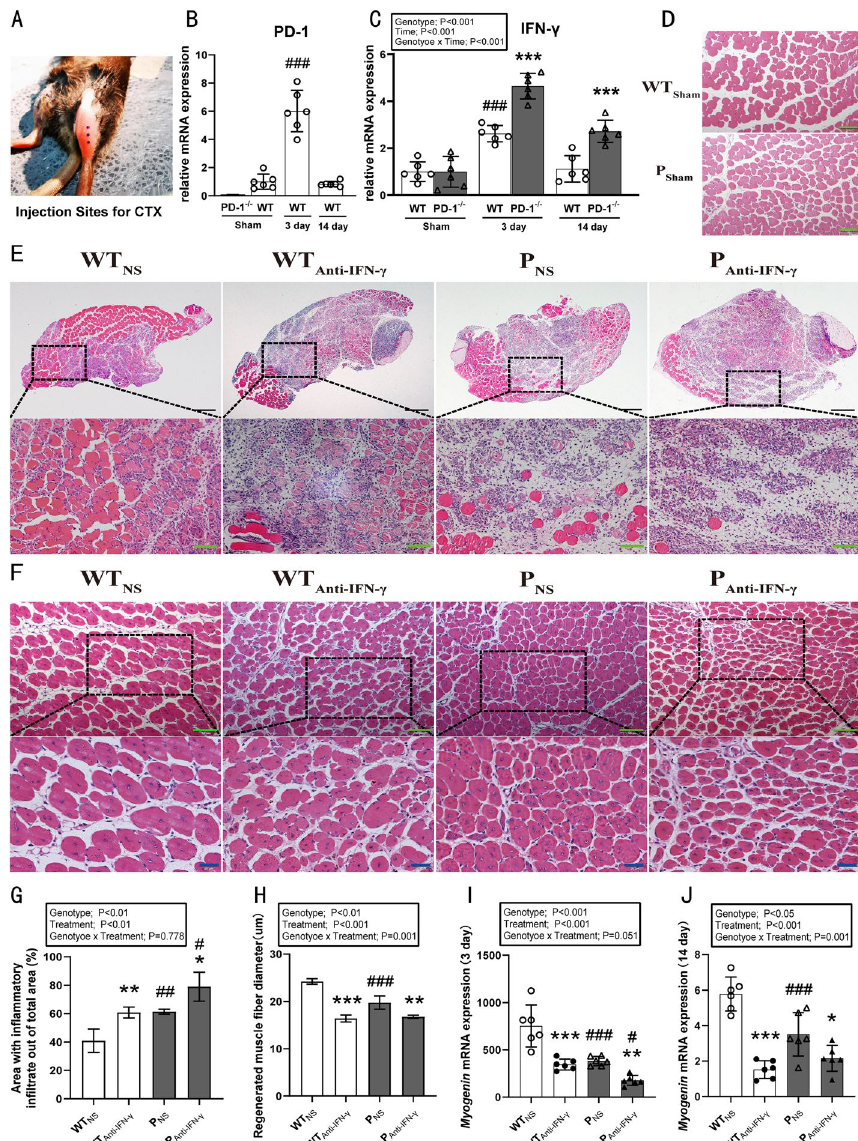
Fig. 1 PD-1 knockout and IFN-γ blockade aggravate muscle damage and impair muscle regeneration. WT Sham : wild-type uninjured group, P Sham : PD-1 − / − uninjured group, WT NS : wild-type injured group with normal saline injection, WT Anti-IFN-γ : wild-type injured group with anti-IFN-γ antibody injection, P NS : PD-1 − / − injured group with normal saline injection, P Anti-IFN- γ : PD-1 − / − injured group with anti-IFN-γ antibody injection. A Injection sites for CTX. B PD-1 mRNA expression in wild-type mice after skeletal muscle injury. C IFN-γ mRNA expression in wild-type mice and PD-1 − / − mice after skeletal muscle injury. (*** P < 0.001, different from WT mice at the same timepoint, different from each other and the PD-1 − / − sham mice. ### P < 0.001, different from WT sham and WT 14-day groups). D hematoxylin and eosin (HE) staining of uninjured tibialis anterior (TA) muscle of mice of both genotypes. E HE staining of injured TA muscle of mice of both genotypes injected with CTX along with either anti-IFN-γ antibody or normal saline at 3-days post injury. F HE staining of injured TA muscle of mice of both genotypes injected with CTX, along with either anti-IFN-γ antibody or normal saline at 14 days post injury. G Quantification of area with inflammatory infiltration as in E . H Quantification of regenerated muscle fiber diameter as in F , I myogenin mRNA expression at 3 days post injury, J myogenin mRNA expression at 14 days post injury. * P < 0.05, ** P < 0.01, *** P < 0.001, different from NS treatment when comparing the same genotype. # P < 0.05, ## P < 0.01, ### P < 0.001, different from WT mice when comparing the same treatment. Data are shown as mean standard deviation (SD), n 6 ( B , C , I , J ), ± = n 3 ( G , H ). Black scale bar, 200 μm; green scale bar, 50 μm; blue scale bar, 20 =